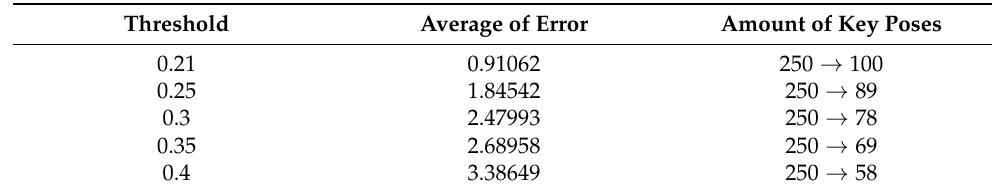
Table 4. Different threshold and its average of error and amount of key poses.